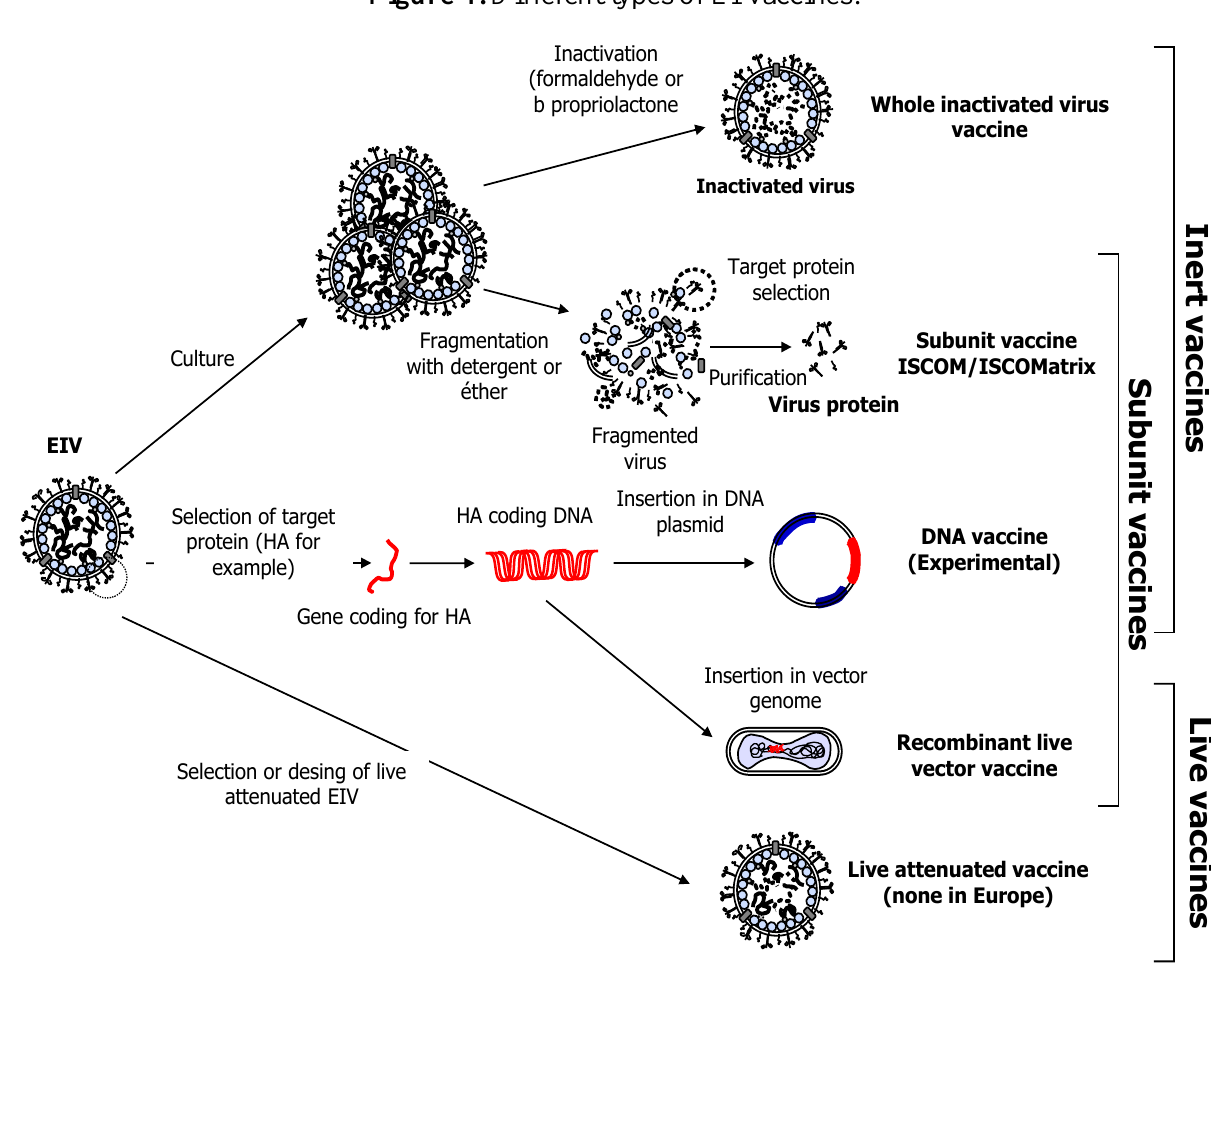
Figure 4. Different types of EI